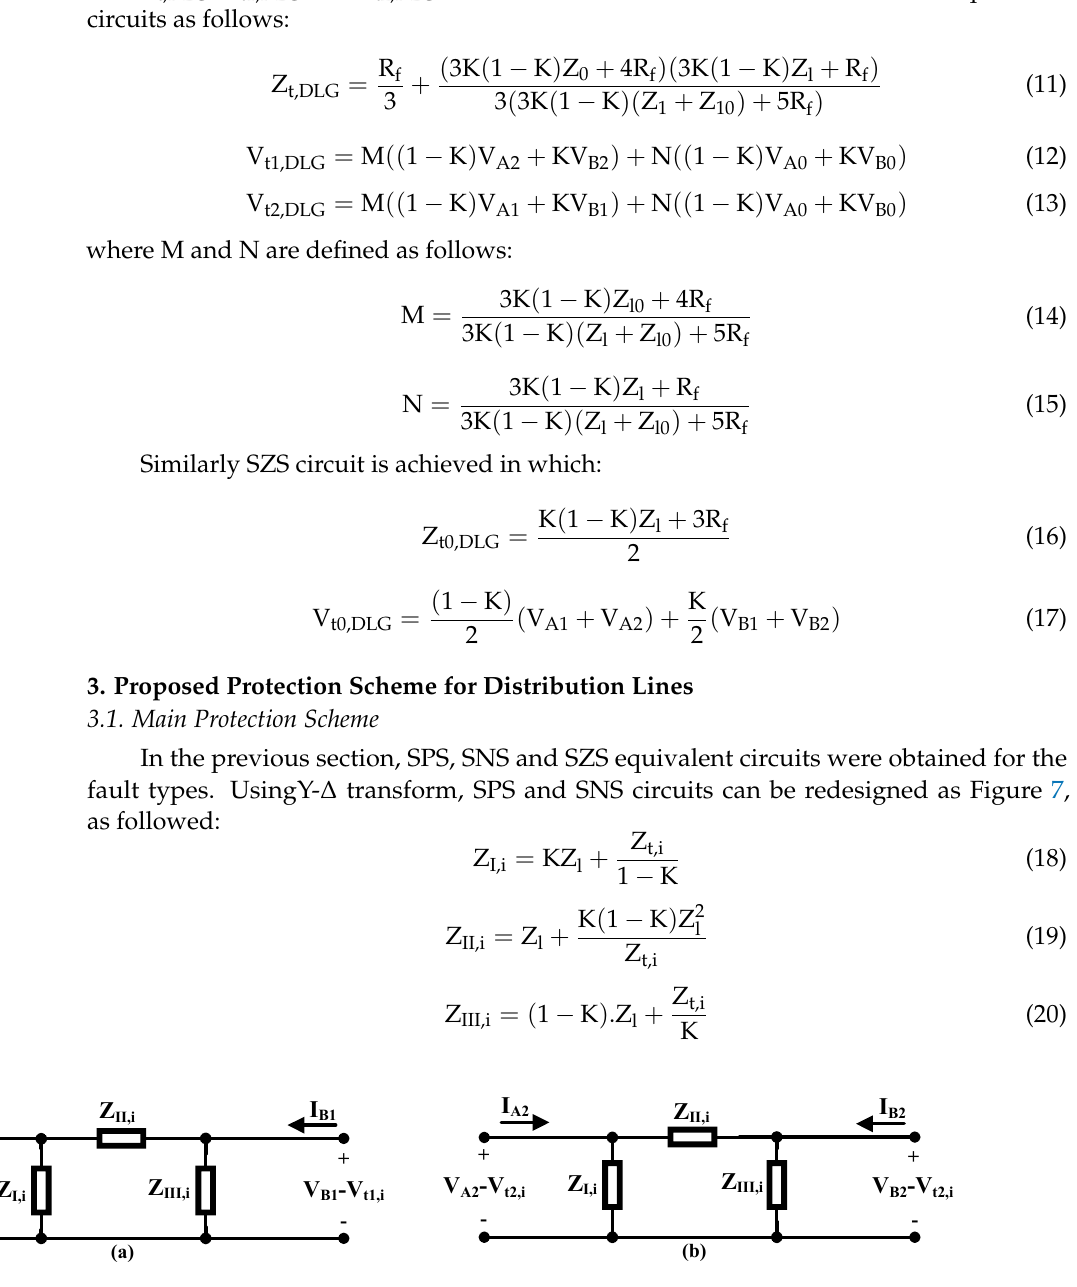
Figure 7. Transformed ( a ) SPS and ( b ) SNS circuit to equivalent delta.